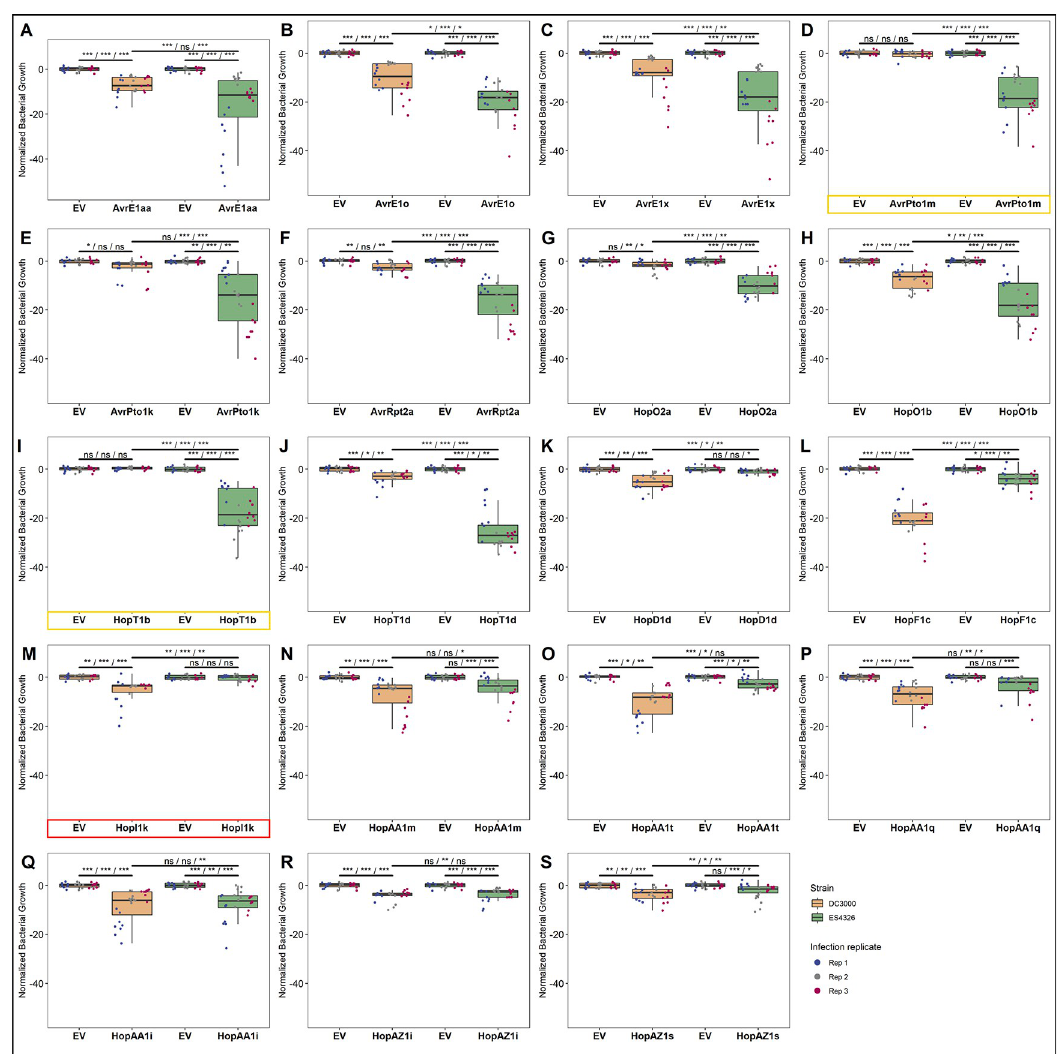
Fig 2. Strain-specific ETI differences are predominantly quantitative. Z-score normalized bacterial growth data for all 19 T3SE alleles that display differential ETI phenotypes when delivered from either (A-J) PmaES4326 or (K-S) PtoDC3000. Asterisks indicate treatments determined to be statistically significantly different based on pairwise T-tests ( � P < 0.5, �� P < 0.1, ��� P < 0.01). Spray inoculation growth assays were performed 3 days post infection. Raw growth assay data is presented in S4 Fig. T3SEs that display qualitative, as opposed to quantitative, differences between strains are highlighted in yellow (PmaES4326-specific) or red